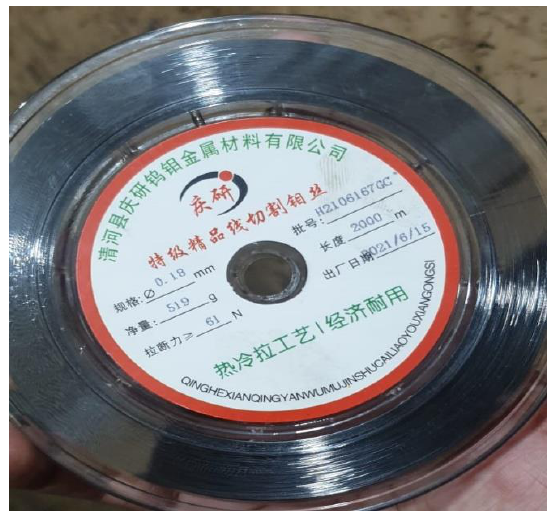
Figure 3. Molybdenum wire. Table 6. Specifications of molybdenum wire.